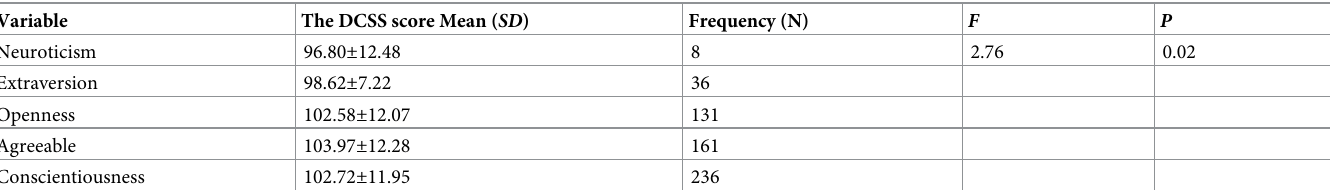
Table 3. Death coping self-efficacy scores of nurses with different personality traits (n = 572).